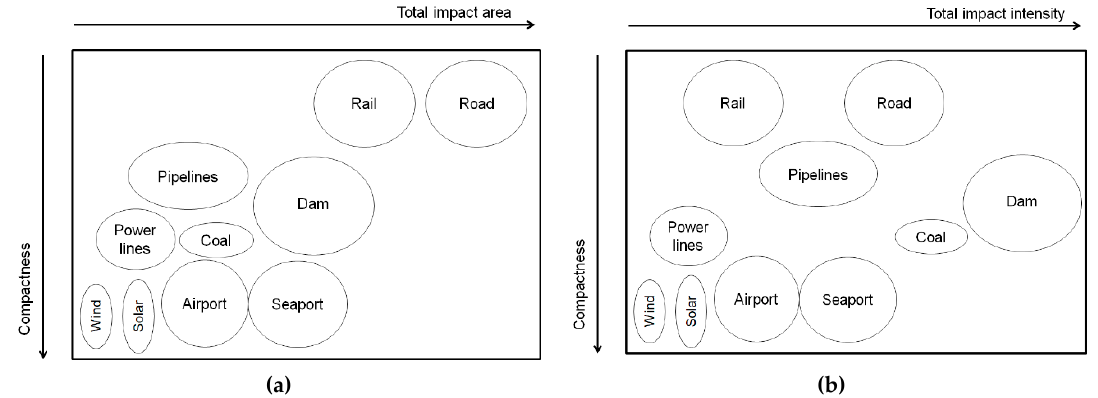
Figure 3. A simplified schematic describing ( a ) total impact area and ( b ) total impact intensity versus compactness of BRI infrastructure types.